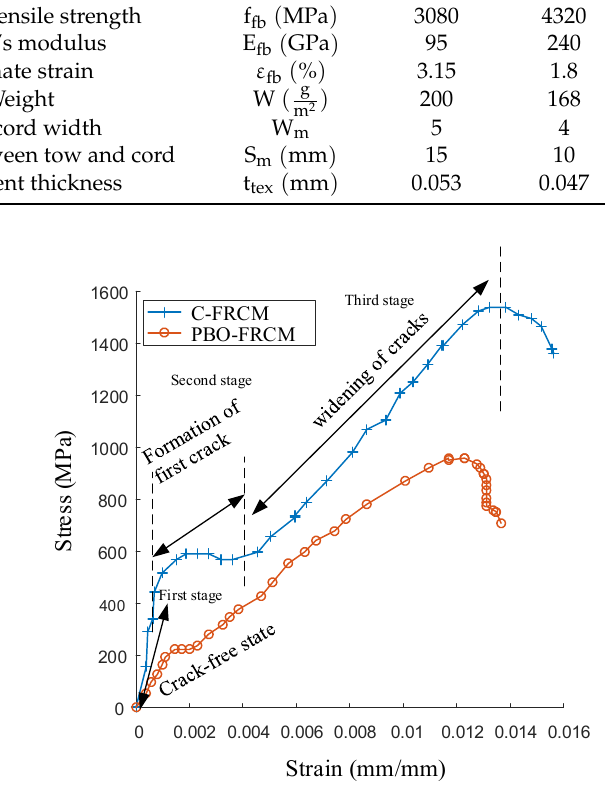
Figure 1. The stress–strain curves for FRCM-tensile coupon.